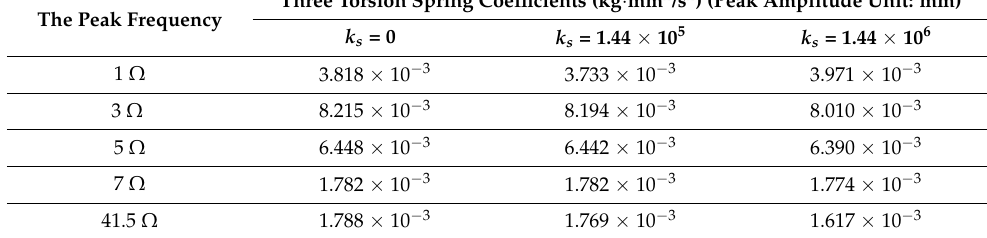
Table 9. The peak amplitude of the lateral vibration spectrum of the follower output node D where Ω = 320 rad/s and with three torsion spring stiffness